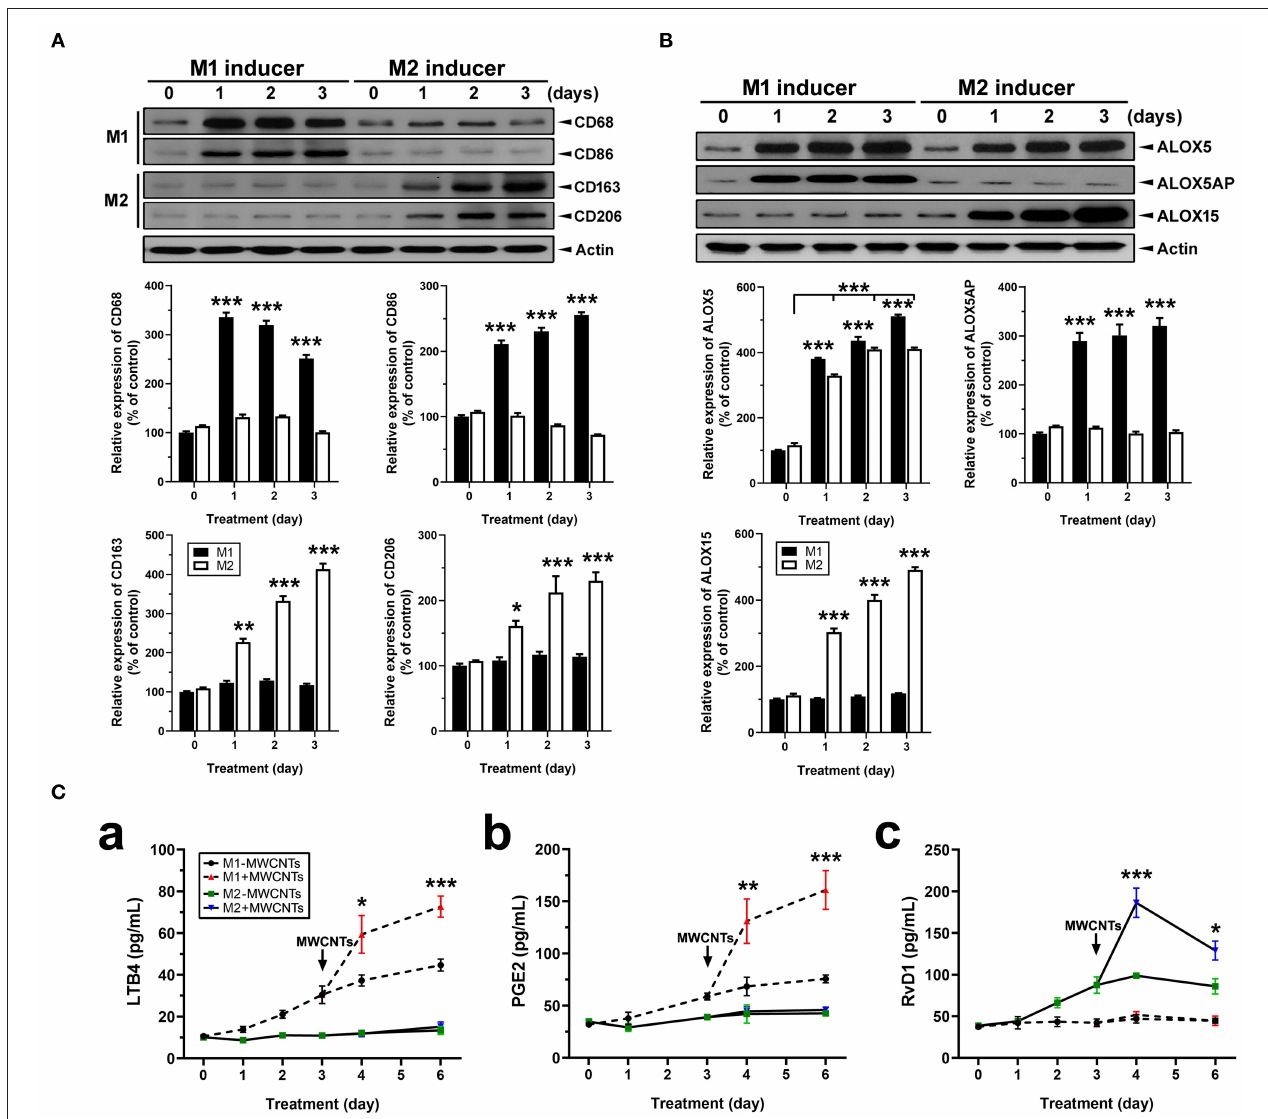
FIGURE 11 | Macrophage polarization, lipid mediator pathway induction, and LM production. (A) Polarization of macrophages in vitro . Macrophage cells (J774A.1) were polarized by treating with M1 inducer (IFN- γ at 20ng/ml plus LPS at 100ng/ml) or M2 inducer (IL-4 at 20ng/ml) for the indicated time. Cells were lysed and analyzed by Immunoblotting against M1 markers CD68 and CD86, M2 markers CD163 and CD206, or β -actin (loading control). Representative image was shown from 3 different experiments. The relative amount of each protein was expressed as % of vehicle control and quantification was shown as mean ± SEM. (B) Expression of ALOX pathway enzymes in M1 or M2 macrophages. M1 and M2 cells were analyzed by immunoblotting against ALOX5, ALOX5AP, ALOX15, or β -actin (loading control). Representative image was shown from 3 different experiments and quantification was shown as mean ± SEM ( n = 3). (C) Effect of MWCNTs on LM production from M1 or M2 macrophages. Macrophages were polarized with M1 or M2 inducer for 3 days. Polarized cells were then treated with DM or MWCNTs (2.5 µ g/ml) for 1, 2, or 3 days. The cell-free culture media were collected for quantification of LTB4 (a), PGE2 (b), or RvD1 (c) using ELISA ( n = 6). * p < 0.05; ** p < 0.01; *** p <